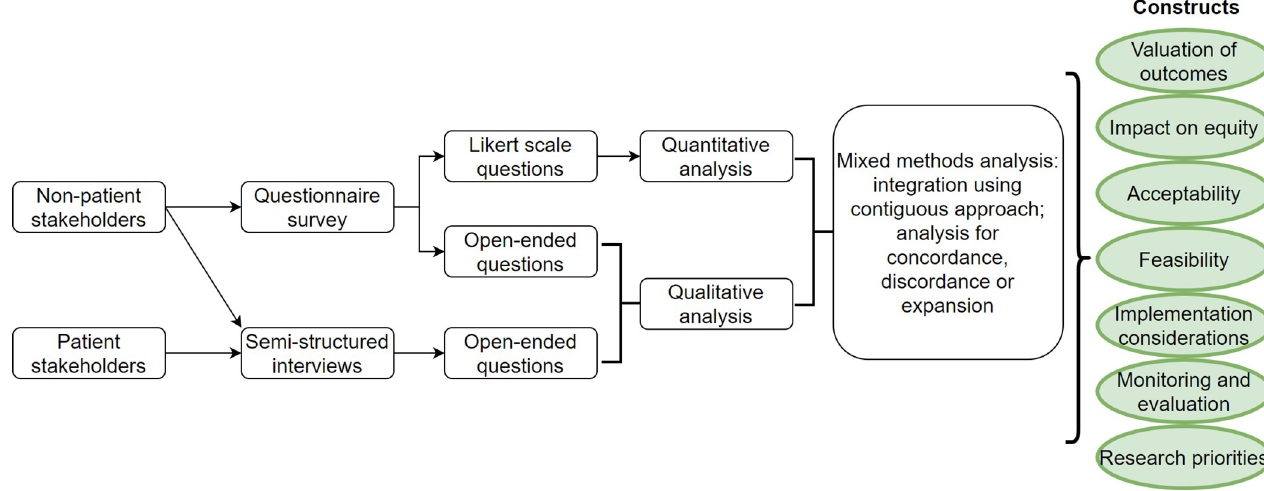
Fig 1. Mixed methods